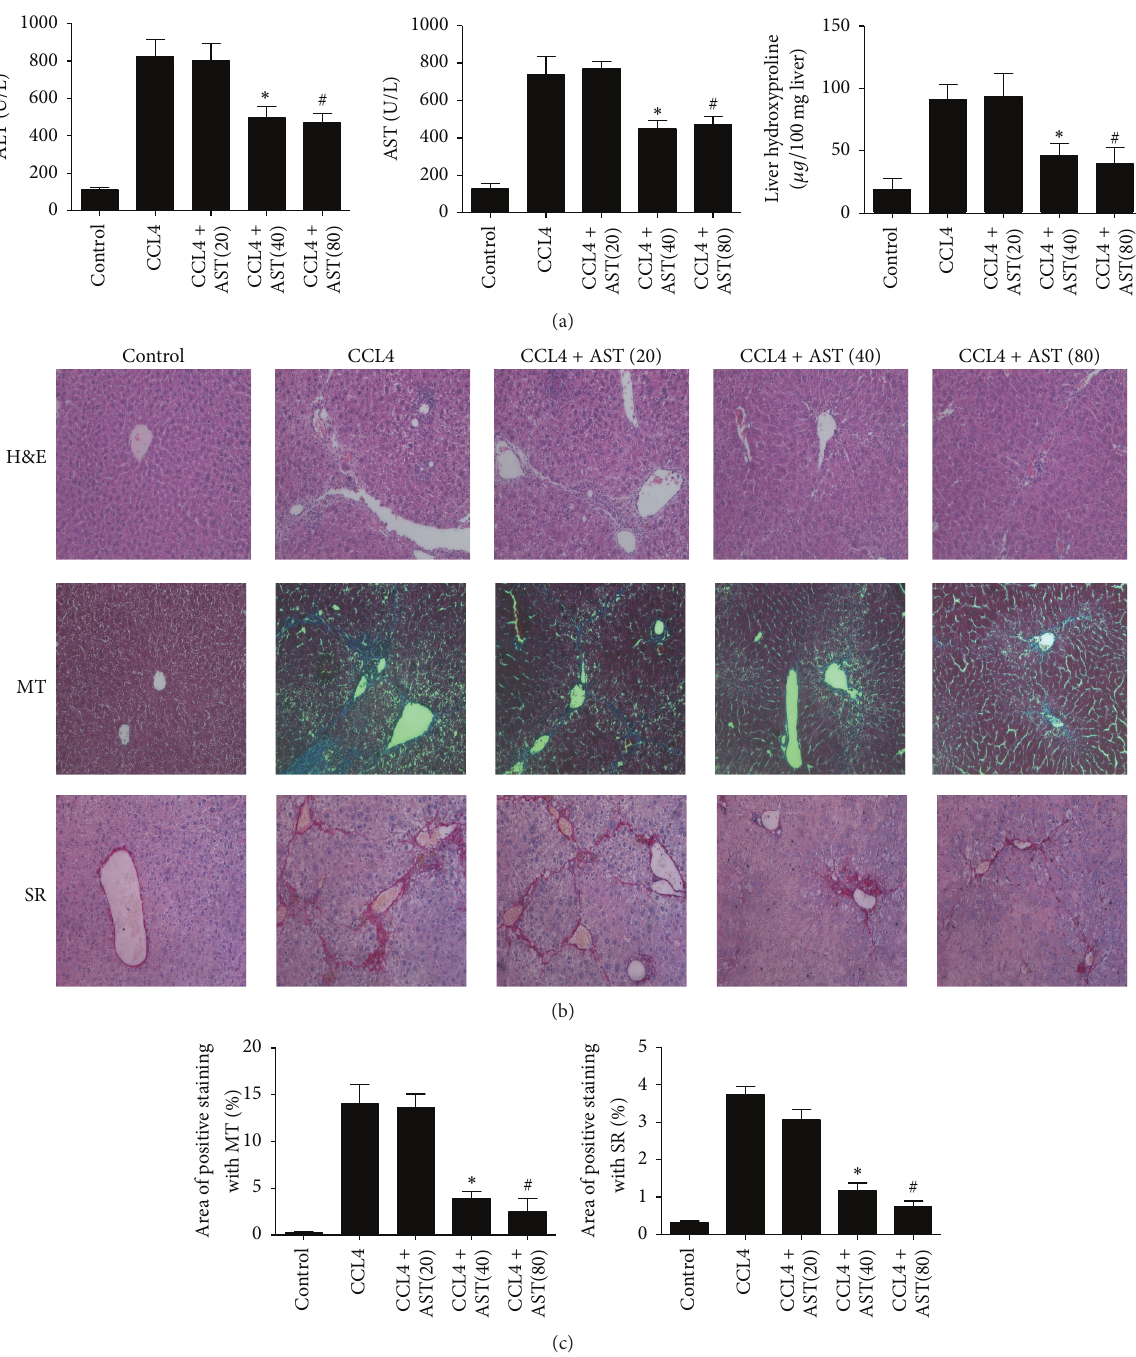
Figure 1: Effect of astaxanthin on CCL4-induced liver fibrosis. (a) Astaxanthin decreased the level of ALT, AST, and hydroxyproline with the doses of 40mg/kg and 80 mg/kg. Data are expressed as mean ± SD ( 𝑛 = 7 , ∗ 𝑃 < 0.05 for CCL4 + AST(40) versus CCL4, # 𝑃 < 0.05 for CCL4 + AST(80) versus CCL4). (b) Astaxanthin (40mg/kg and 80 mg/kg) ameliorated pathological change showed by H&E, Masson’s trichrome (MT), and sirius red staining (original magnification: ×200 ). (c) The areas of positive staining with MT and SR were analyzed by Image-pro Plus 6.0. There existed a significant decrease with astaxanthin (40 mg/kg and 80 mg/kg) treatment ( 𝑛 = 7 , ∗ 𝑃 < 0.05 for CCL4 + AST(40) versus CCL4, # 𝑃 < 0.05 for CCL4 + AST(80) versus